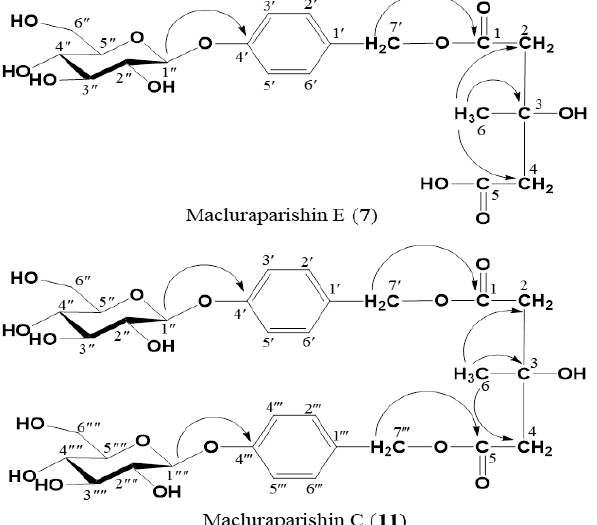
Figure 5. Key correlations in the HMBC experiments and chemical structures of novel parishin compounds identified from MT twig.